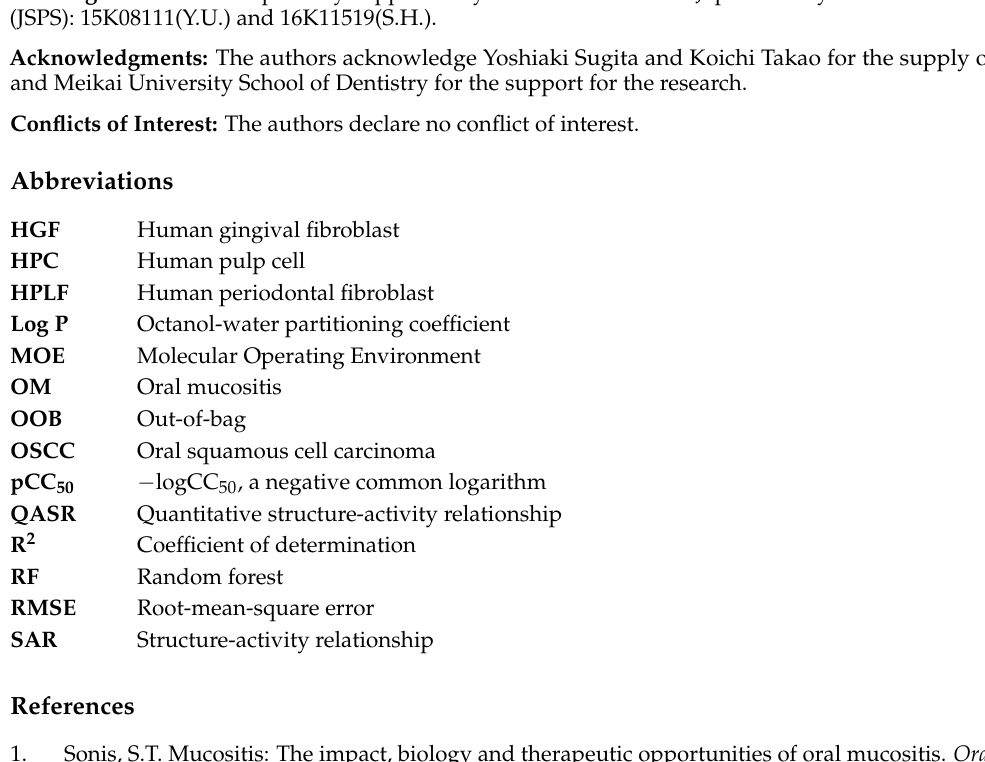
Table S1: SMILES of 494